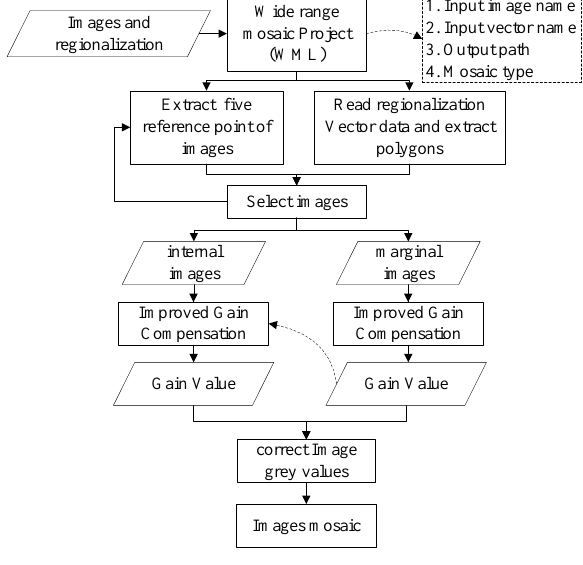
Figure 11. The algorithm flow of the color balancing method for wide range remote sensing imagery based on regionalization